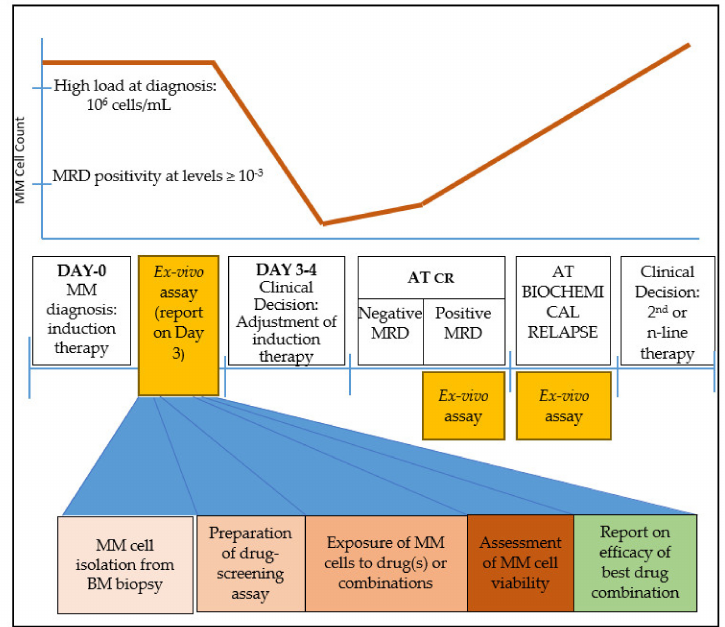
Figure 1. Clinical timeline of multiple myeloma (MM) treatment and suggested timing for ex vivo drug-screening assay. An abundance of MM cells is critical for the successful performance of the assay. Such windows appear immediately after diagnosis, at complete response (CR) when minimal residual disease (MRD) contains su ffi cient tumor burden, and at biochemical relapse. The steps for a clinically relevant ex vivo screening assay are sample collection and MM cell isolation in adequate numbers; exposure of cells to the drug(s); assessment of cell viability; and finally a report on the most e ff ective drug(s) or drug